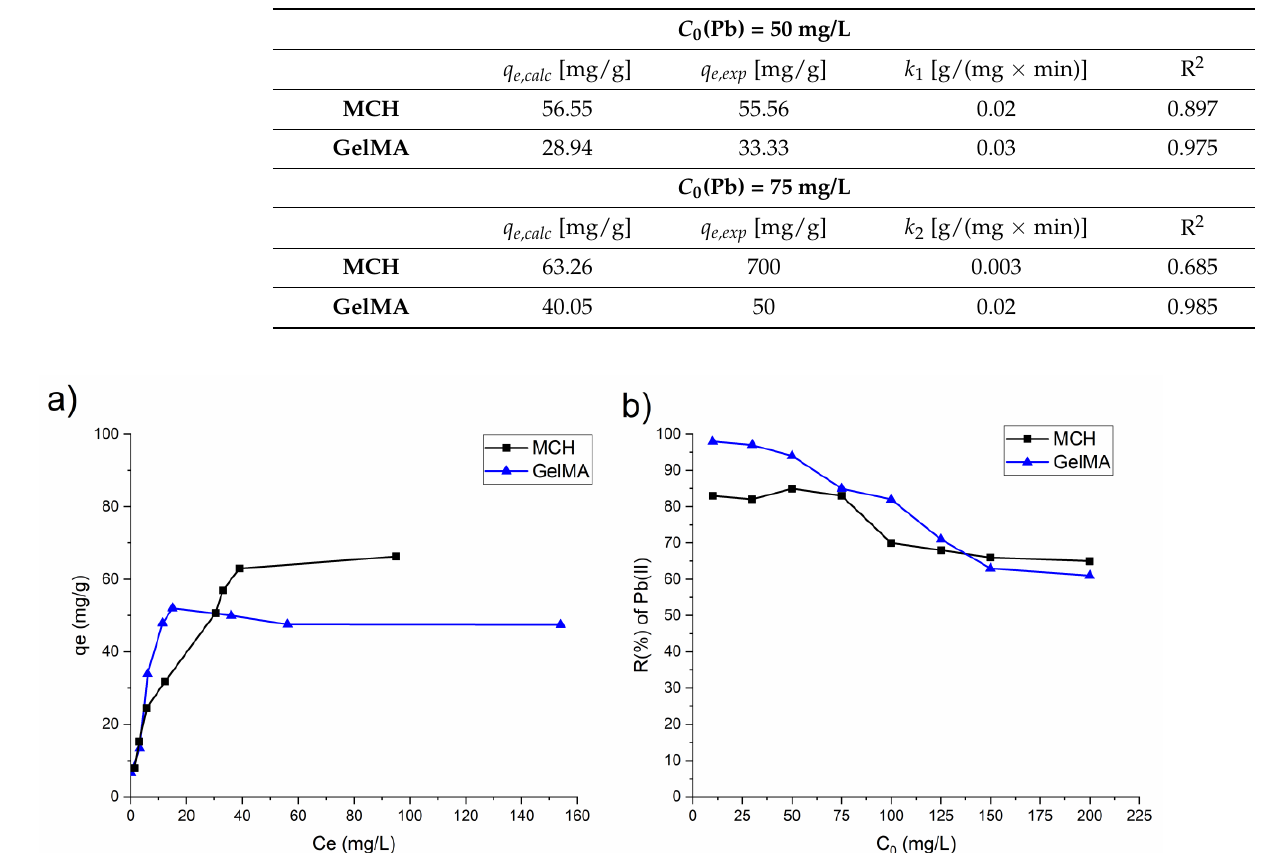
Table 4. Pseudo-second order fitting parameters for Pb(II) adsorption.